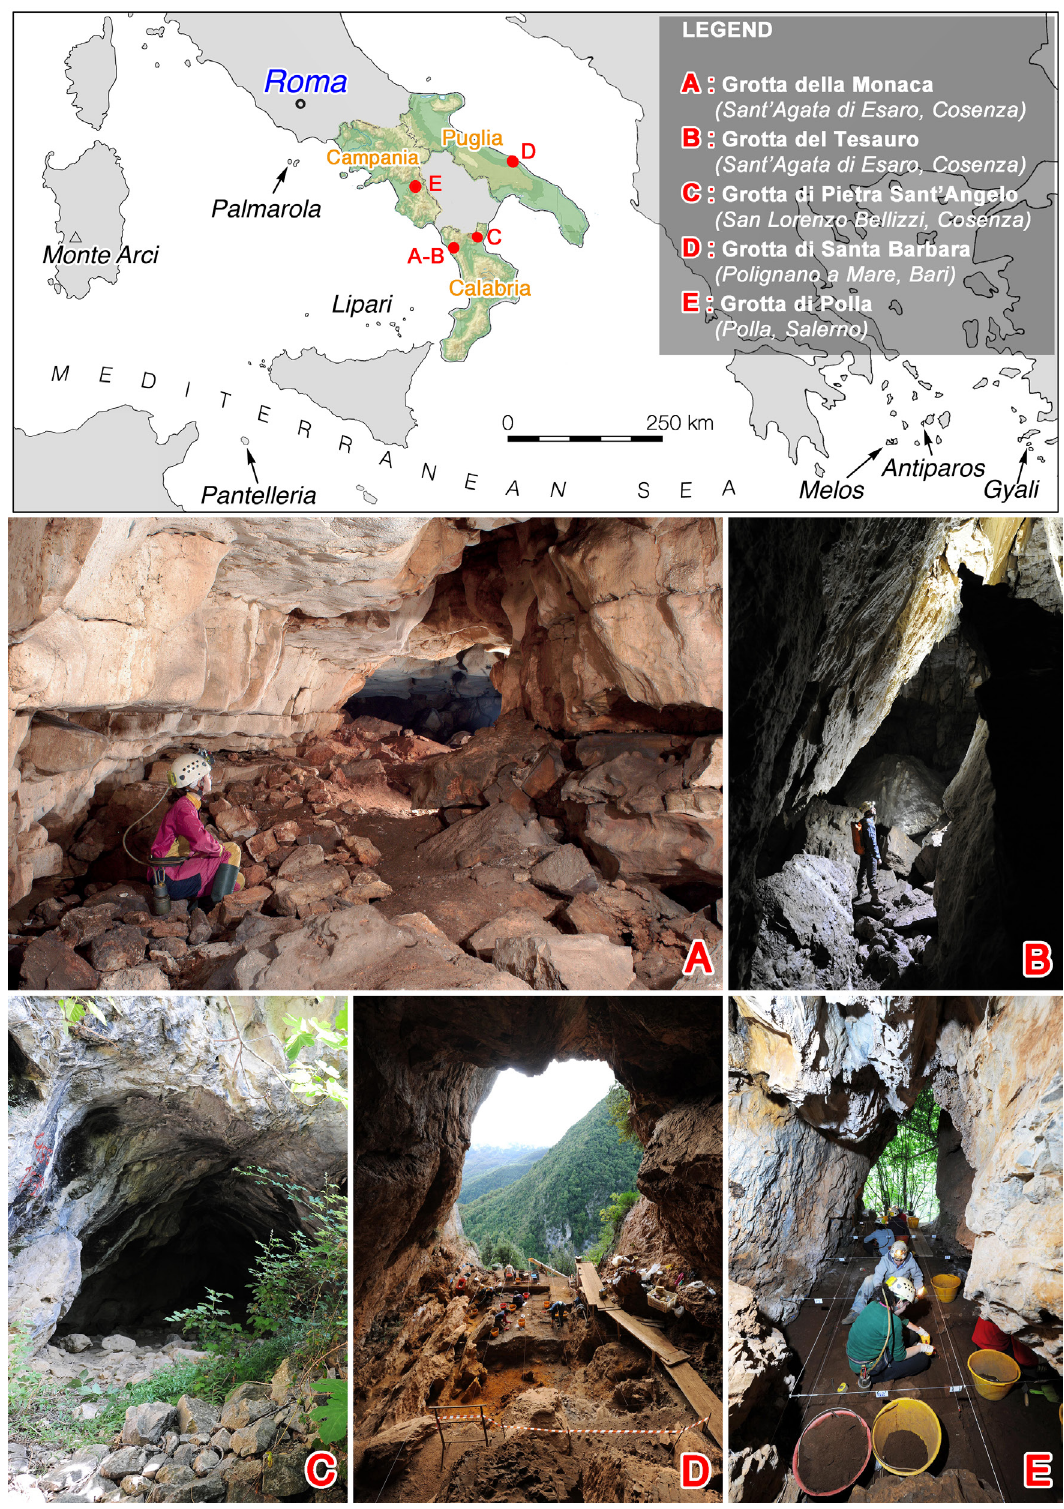
Figure 1: Studied archaeological sites and Mediterranean obsidian source area. In black is the name of the central-eastern Mediterranean source area. The geographic position in Southern Italy of the studied karst cavities and the relative photo- graphs are indicated with an uppercase red letter (photographs by F. Larocca); in orange are specified the Southern Italy province which house the karst